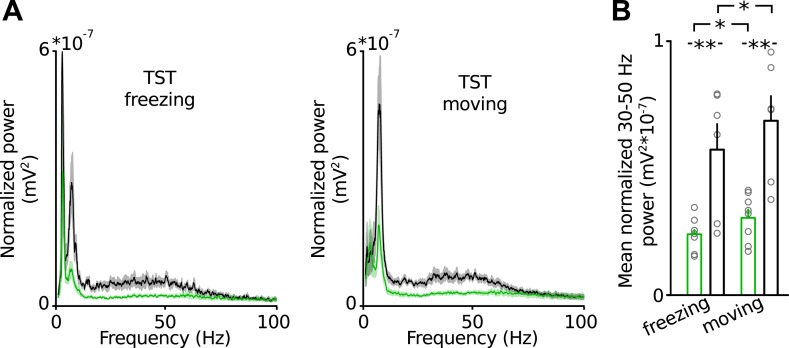
Unchanged hippocampal-prefrontal theta coherence.(A) Average coherence during TST and baseline revealed a sharp peak in the delta frequency range in both genotypes. Solid lines are mean, shaded areas SEM. (B) There is no difference in the average coherence (6–12 Hz) between Disc1 and control mice (n = 4 Disc1, 3 control mice). Data are mean ± SEM.